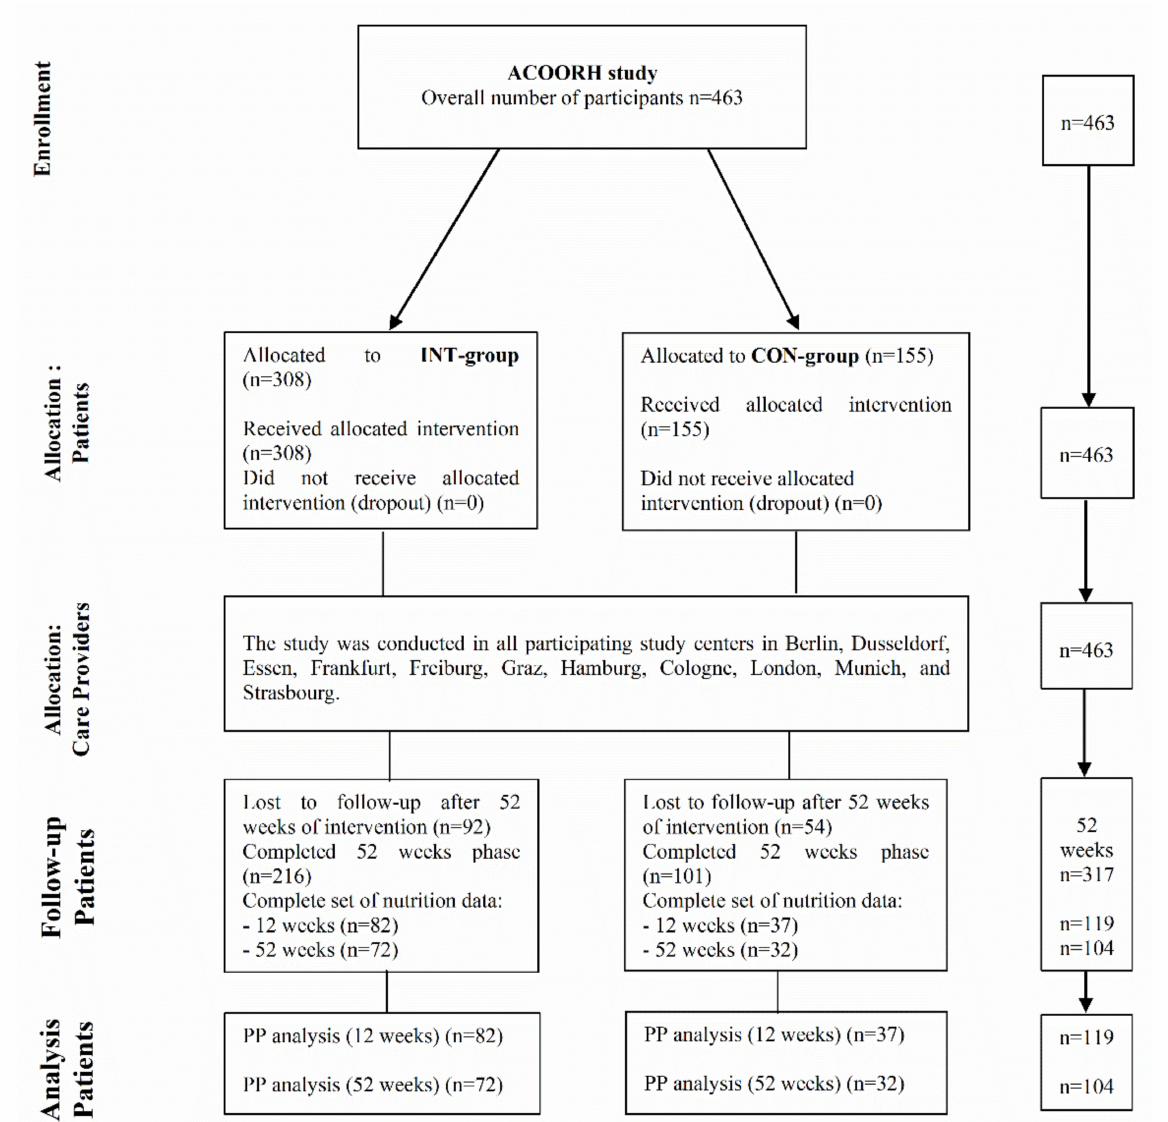
Figure 1. Study flow chart. CON-group, lifestyle intervention control group; INT-group, meal replacement-based lifestyle intervention group; PP, per-protocol